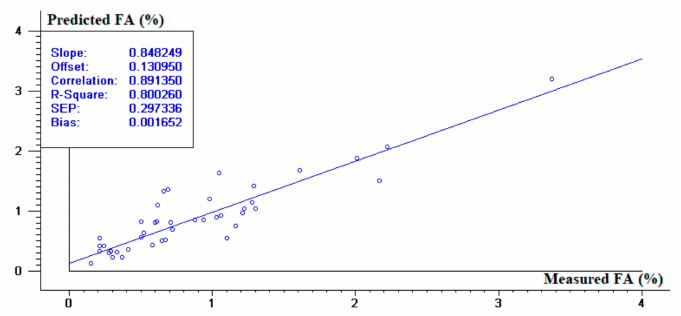
Figure 6. Validation of the 950–1650 PLS model for FA